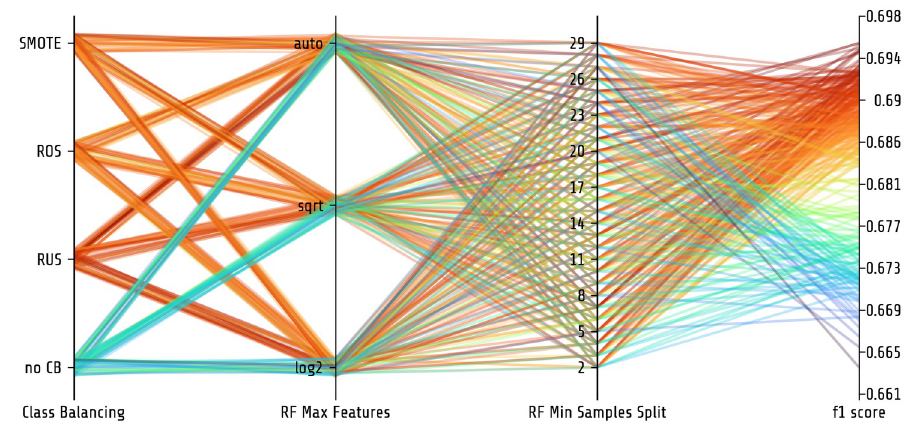
Fig 4. Parallel plot showing hyperparameter exploration. All three hyperparameters used in the final model are shown on the x-axis. They include the class balancing algorithm and two hyperparameters of the Random Forest classifier (maximum number of features and minimum samples per split). Each line represents a specific combination of all hyperparameters. The line color reflects the corresponding model performance based on the f1 score. Higher model performance is shown in dark red while lower model performance is shown in blue. Random under-sampling appears to increase model performance slightly while using no class balancing algorithm decreases overall model performance. CB = class balancing, RUS = random under-sampling, ROS = random over-sampling, SMOTE = synthetic minority oversampling technique, RF = Random Forest.